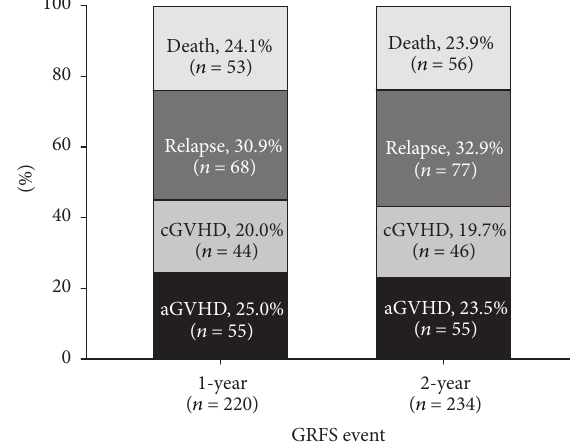
Figure 3: Distribution of individual components between 1-year GRFS and 2-year